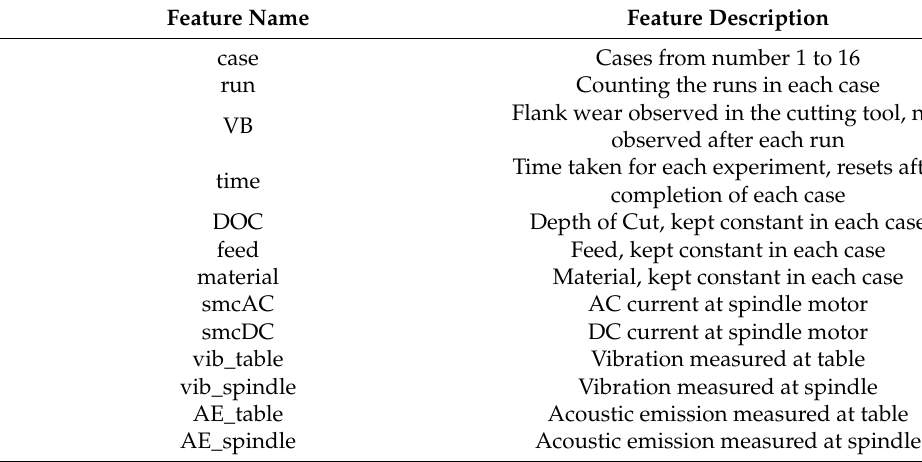
Table 4. Features of the milling dataset and their